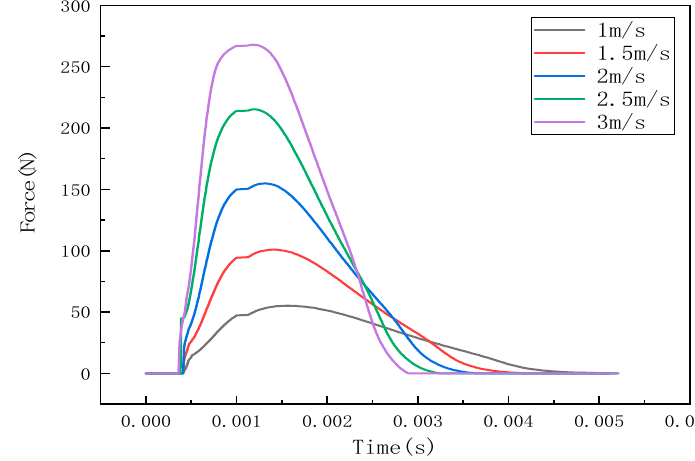
Figure 7. Impact force curve at position 1.